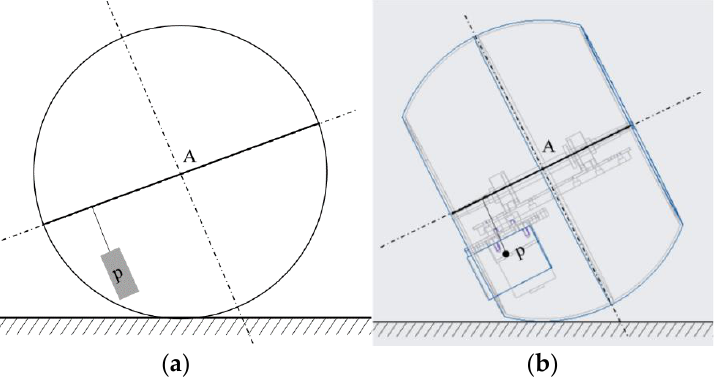
Figure 5. ( a ) The simplified model of the steering motion of the spherical robot; ( b ) The schematic diagram of the counterweight position in steering motion.